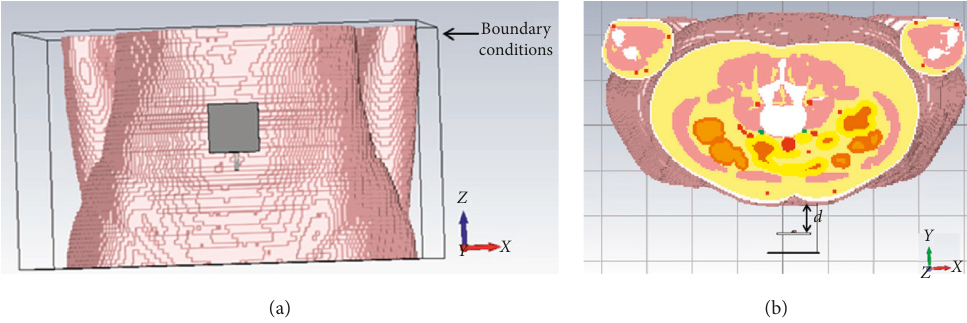
Figure 15: Designed reflector-backed antenna next to the voxel model seen in (a) front and (b) side views.